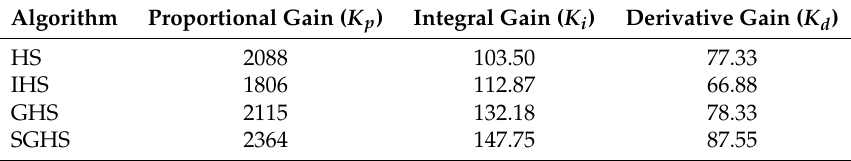
Table 3. PID parameters obtained by optimization